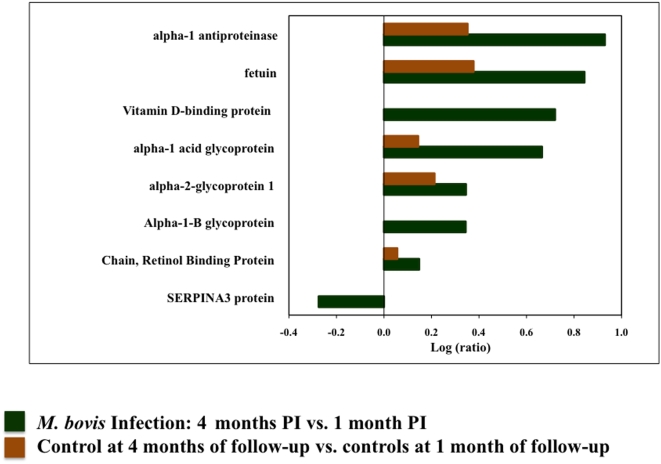
Biomarkers identified in M. bovis infection.The bar graph represents the log ratios of the proteins (P<0.05, EF<2) identified in M. bovis infected and control animals. The green bars represent log ratios of serum biomarkers between 4 months and 1 month PI with M. bovis. Shown in red are ratios in within contemporary controls over time. Levels of D-binding protein and alpha-1 B glycoprotein increased as M. bovis infection progressed, while that of serpina3 protein decreased. Serum amyloid A1 levels increased only in the control animals over time.